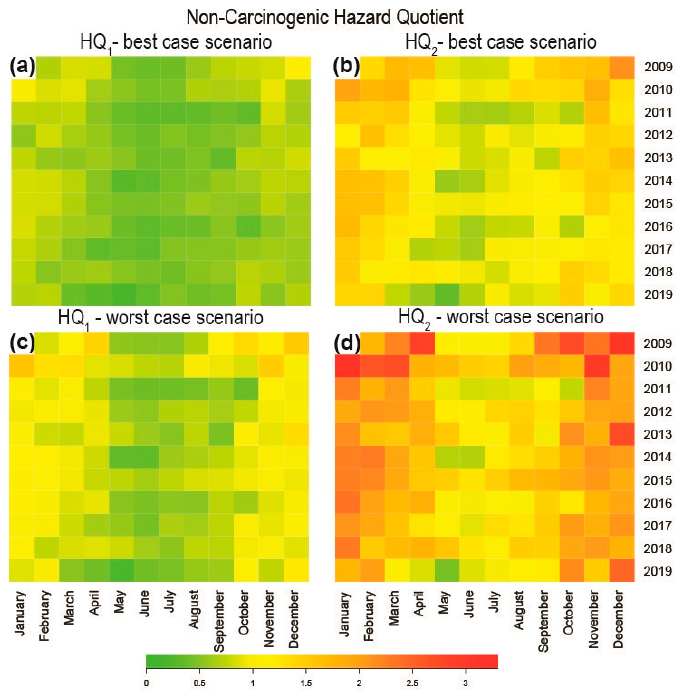
Figure 4. Temporal variation of hazard quotient ( HQ ) calculated based on EU limit values for best-case ( a ) and worst-case ( b ) scenarios, and calculated based on World Health Organization air quality guideline for best-case ( c ) and worst-case ( d ) scenarios in Cluj-Napoca city for 2009–2019.